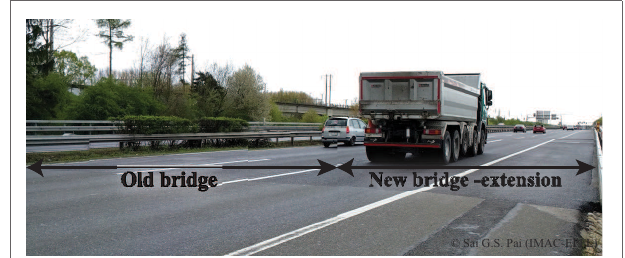
FIGURE 1 | Venoge bridge (Credit: IMAC,